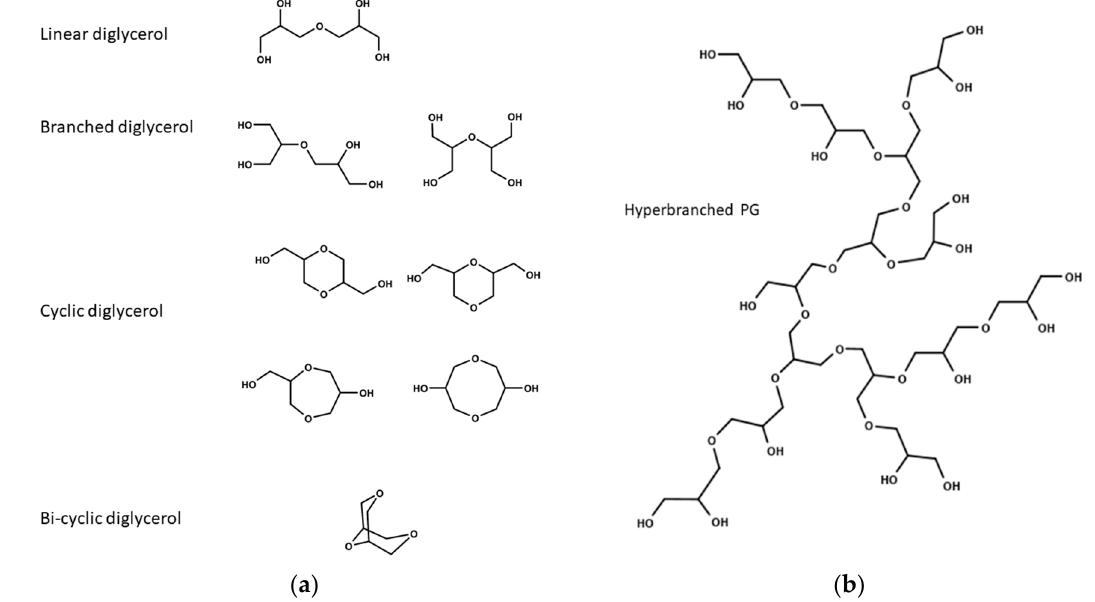
Figure 1. Different structures of: diglycerol including linear, branched and cyclic ( a ) (reproduced from [14]); and a hyperbranched PG (PG14) ( b ) (reproduced from [17]).